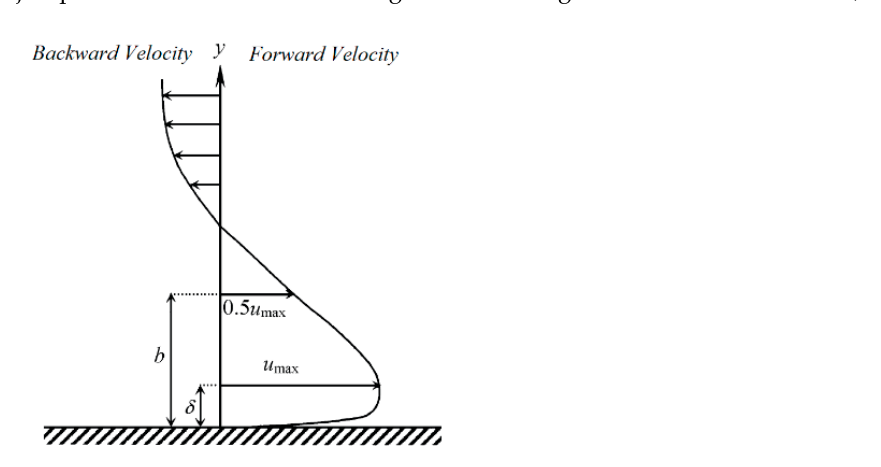
Figure 10. Typical vertical distribution of the mean horizontal velocity in a submerged hydraulic jump [46].